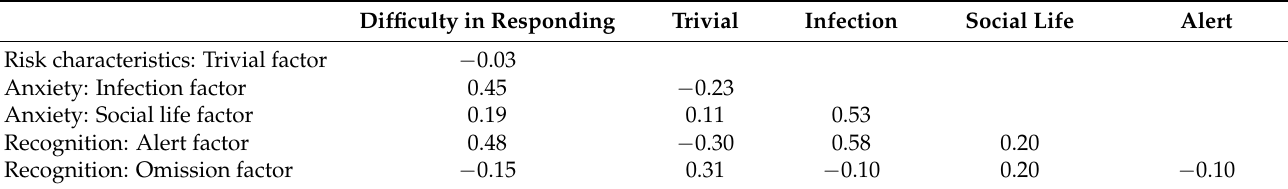
Table 4. Correlation between cognitive